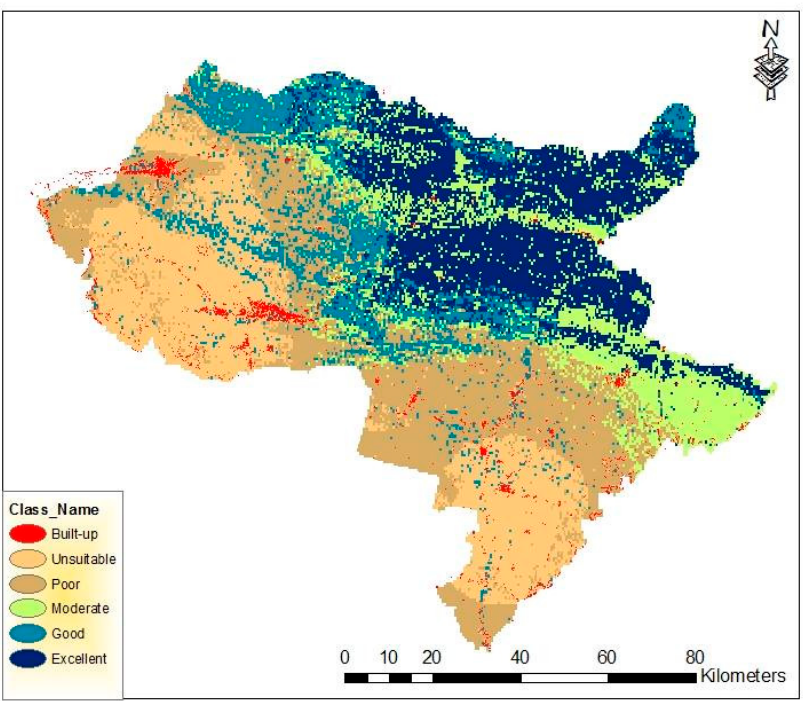
Figure 5. Rainwater harvesting potential map for the study area.